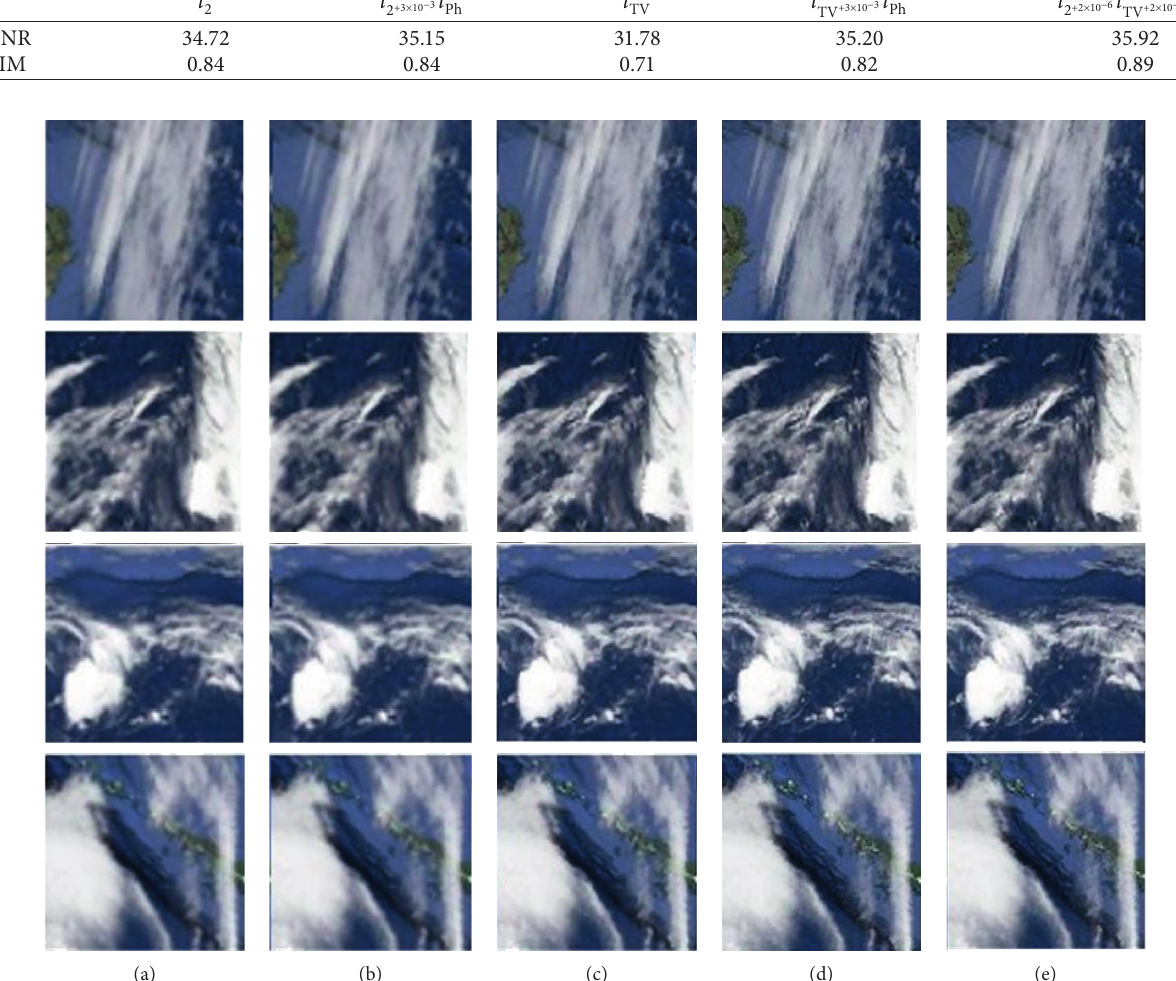
Figure 3: Comparison of superresolution results for visible images (4 × ). (a) Degraded image. (b) Bicubic. (c) ZSSR. (d) MSLp. (e) Real